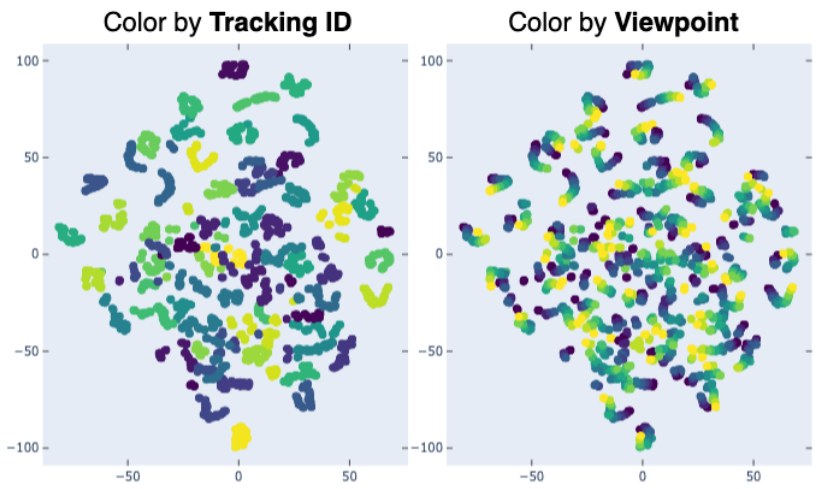
Figure 8. t-SNE [57] visualization of the embeddings from the evaluation set from CASIA-B, as outputted by WildGait, colored by tracking id ( left ) and camera viewpoint ( right ). It is clear that sequences pertaining to the same IDs are close to each other, irrespective of